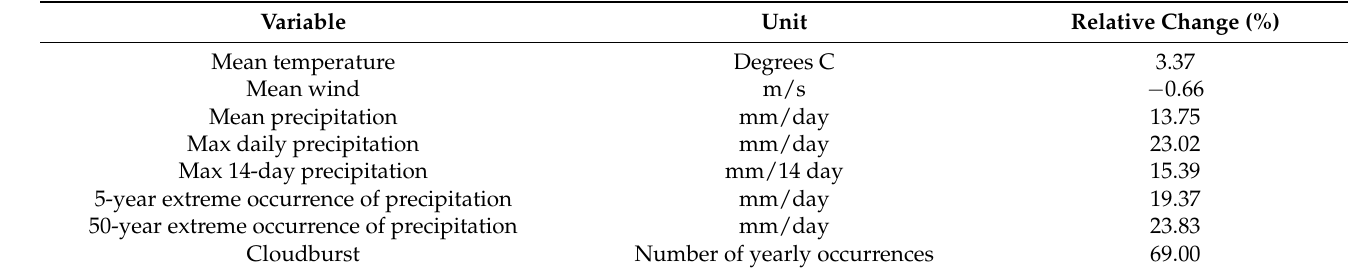
Table 3. Overview of the chosen climatic variables, their units, and the relative change in percent between 1981–2010 and 2071–2100 for the whole of